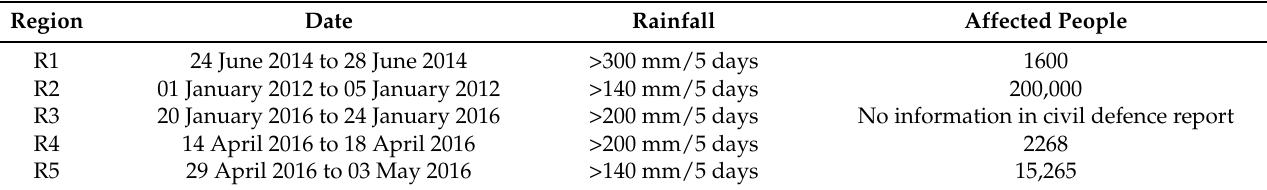
Table 2. Summary of the extreme rainfall events from each region.